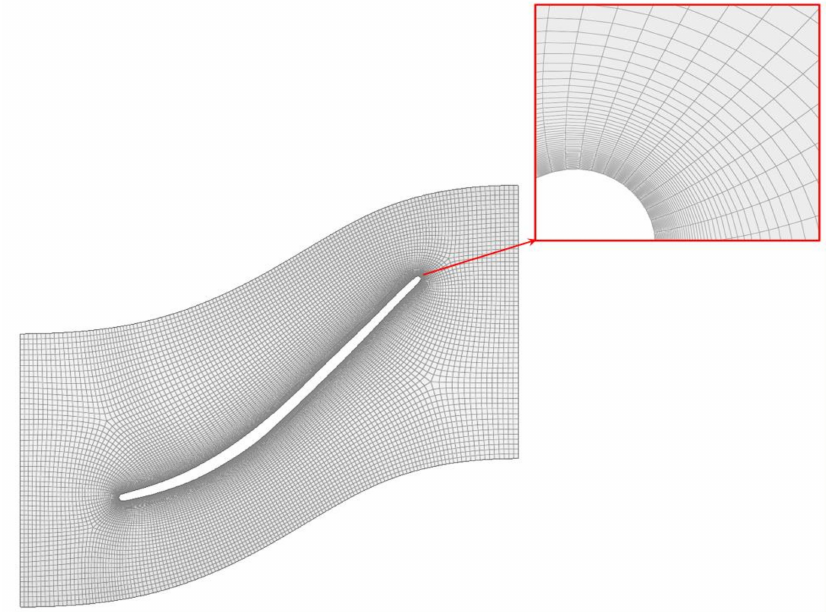
Figure 4. Turbine blade mesh topology of the iSTC-21v jet